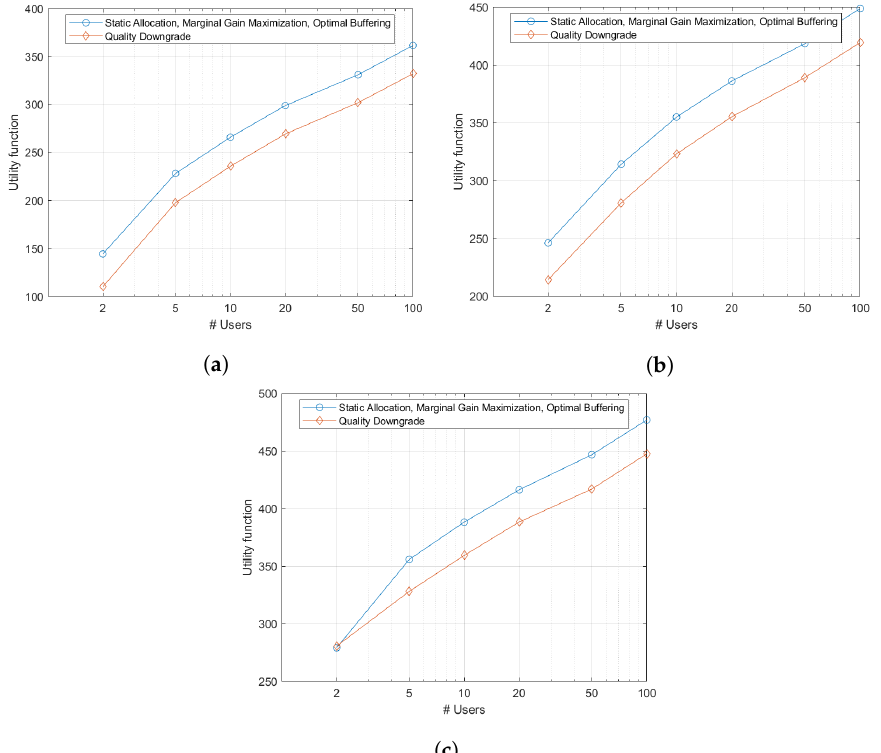
Figure 4. Utility function with variable number of users. ( a ) Short videos. ( b ) Medium videos. ( c ) Long